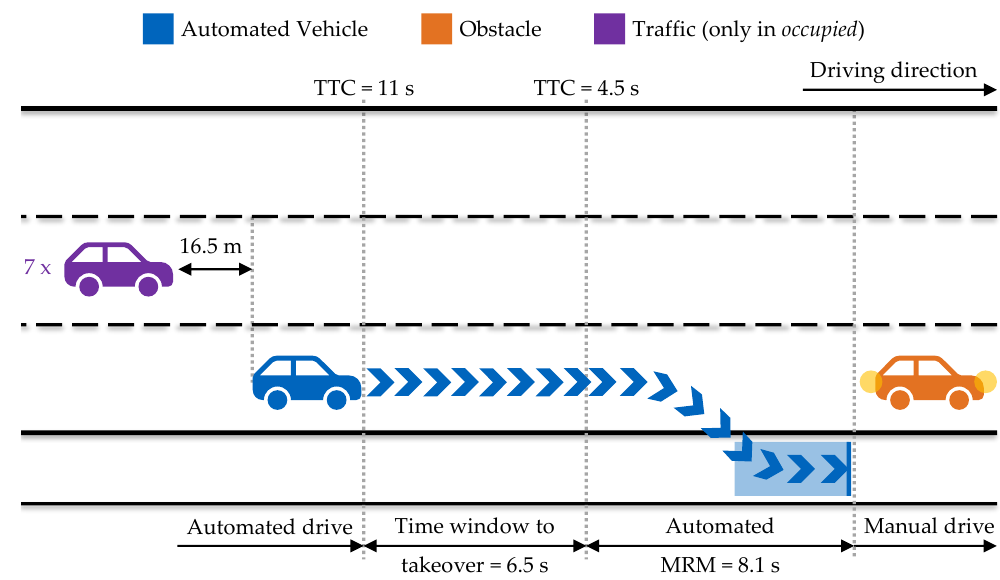
Figure 1. Schematic illustration of the transition design and two scenarios ( free and occupied